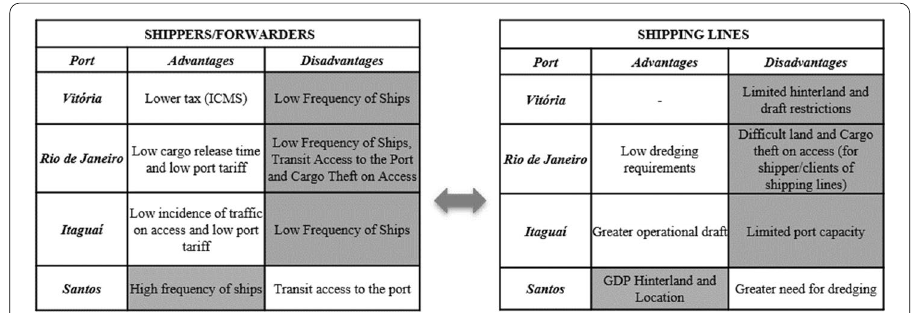
Fig. 9 Advantages and disadvantages in the perspective of shippers/forwarders and shipping